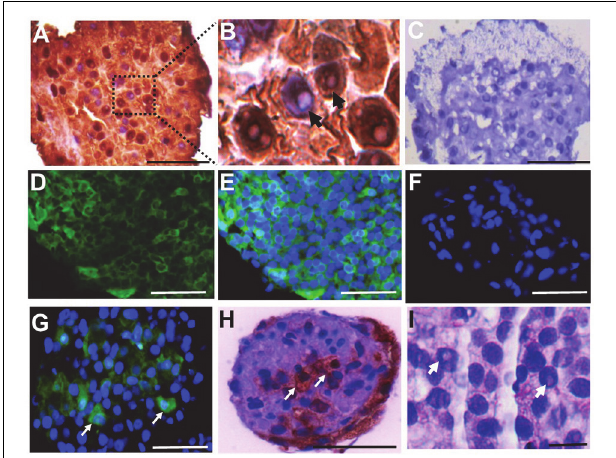
FIGURE 4 | SSCLC containing LIN28 + and UCHL1 + cells with rarefaction zones. Immunostaining of cross sections of primary SSCLCs by (A) , anti-LIN28 in brown and hematoxylin staining shown in blue. Scale bar: 50 µ m. (B) , higher magnification (100 × in microscope) of A illustrating rarefaction zones in nucleus. Arrows showing the rarefaction zones in the nuclei. (C) , negative control for IHC. Scale bar: 50 µ m. (D) , UCHL1, Scale bar: 50 µ m. (E) , UCHL1, and DAPI merged. Scale bar: 50 µ m. (F) , Negative control for immunofluorescence staining of UCHL1. Scale bar: 50 µ m. (G) , UCHL1 and DAPI merged cluster of passage 3. Green is UCHL1, blue is DAPI. Arrows showing the UCHL1 positive cells in SSCLCs. Scale